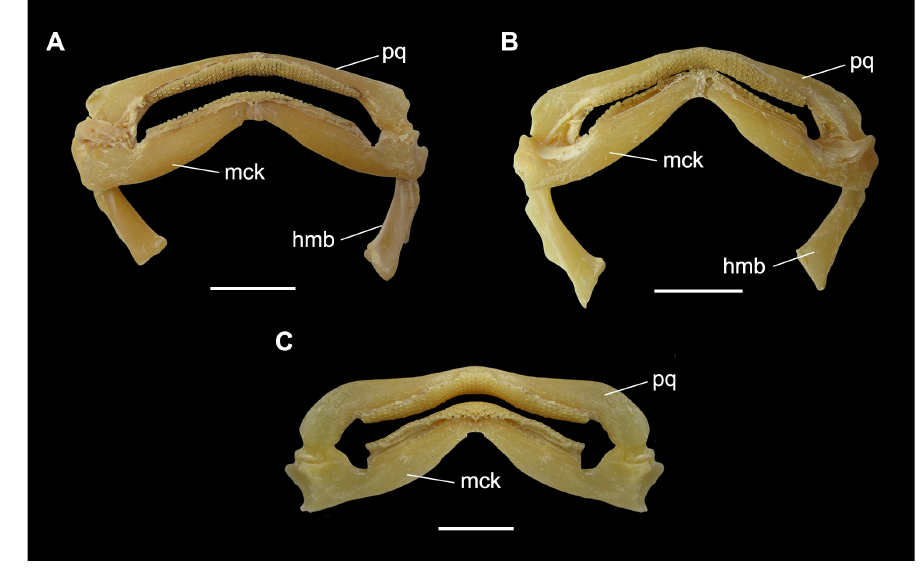
FIGURE 17 | Jaws and hyomandibular cartilage of Atlantoraja species. A , A. castelnaui ., UERJ 1853, male, 593 mm TL. B , A. platana , UERJ 1383, male, 372 mm TL; C , Atlantoraja cyclophora , MNRJ 117184, female, 583 mm TL. hmb , hyomandibula; mck , Meckel’s cartilage; pq , palatoquadrate. Scale bars = 20